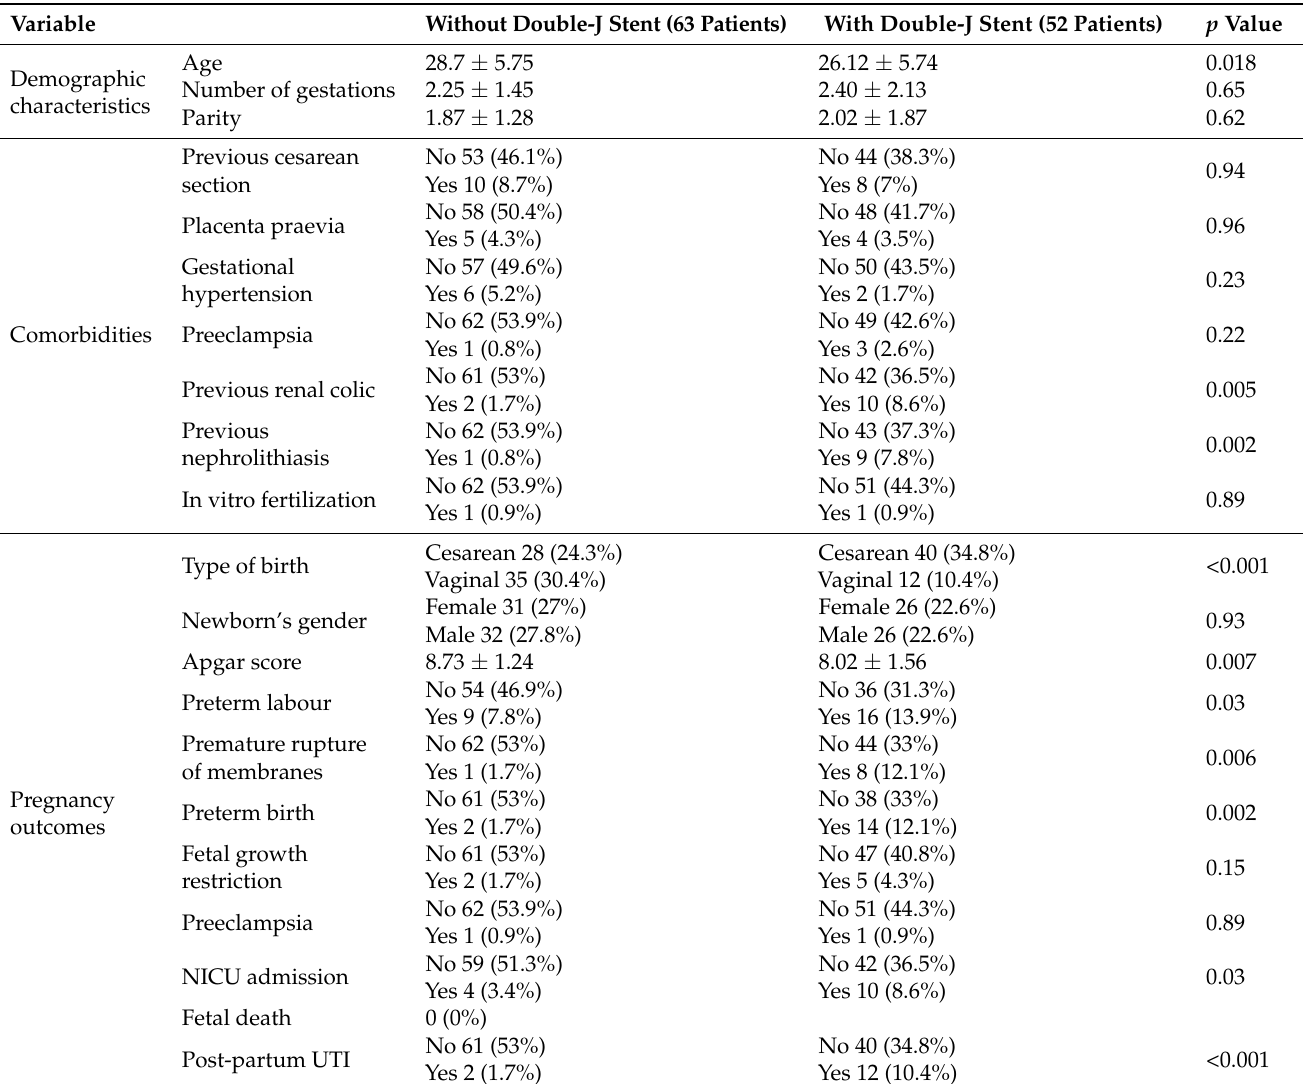
Table 1. Demographic characteristics, comorbidities, and pregnancy outcomes of the evaluated